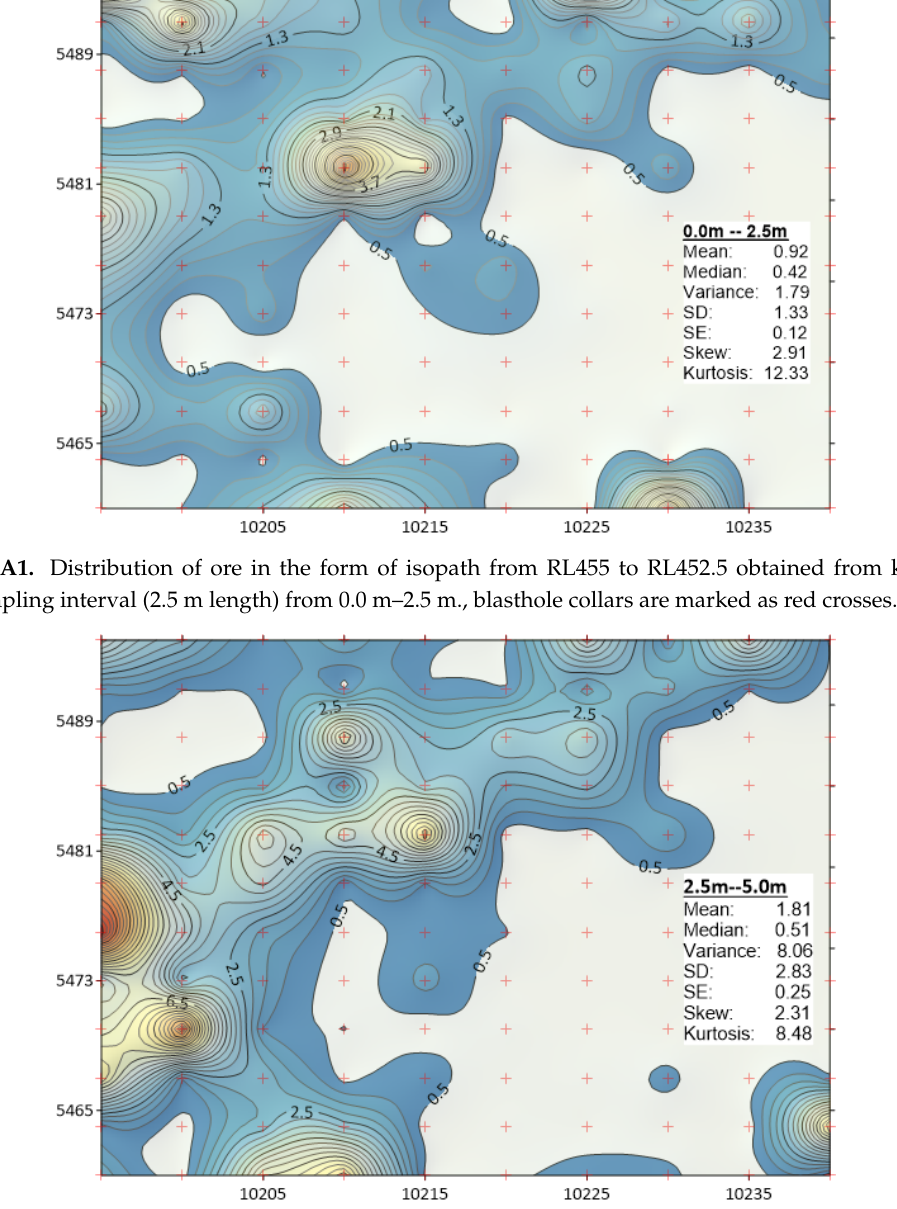
Figure A2. Distribution of ore from RL452.5 to RL450, kriging, sampling interval 2.5 m–5.0 m. The trend in higher grades is